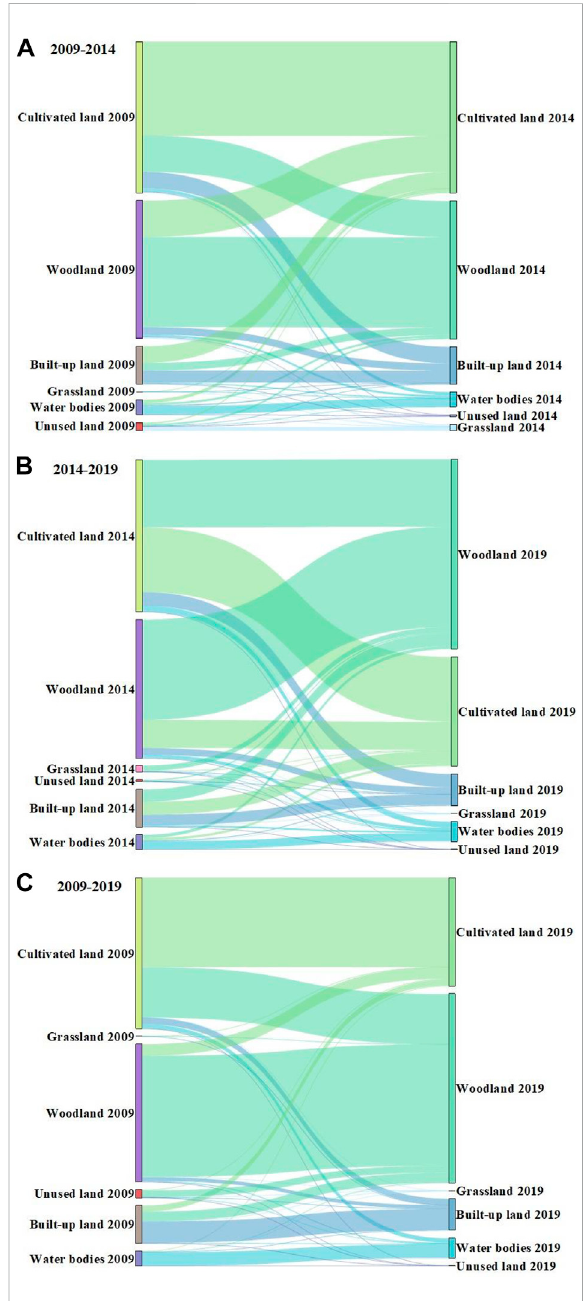
FIGURE 5 Mulberry map of land use change in Jiangjin during 2009 – 2019. (A) :thearea oflanduse change inJiangjin from2009 to 2014; (B) : the area of land use change in Jiangjin from 2014 to 2019; (C) : the area of land use change in Jiangjin from 2009 to